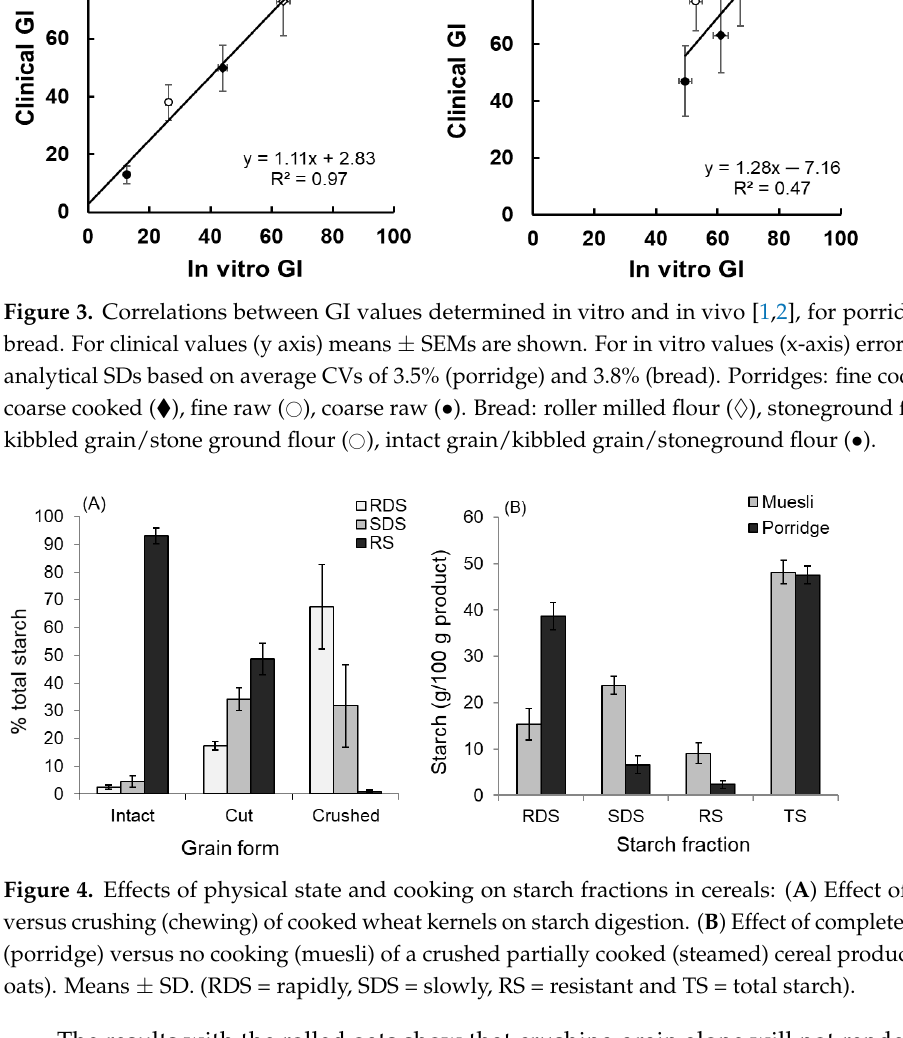
Figure 3. Correlations between GI values determined in vitro and in vivo [1,2], for porridges and bread. For clinical values (y axis) means ± SEMs are shown. For in vitro values (x-axis) error bars are analytical SDs based on average CVs of 3.5% (porridge) and 3.8% (bread). Porridges: fine cooked (◊), coarse cooked ( ♦ ), fine raw ( ○ ), coarse raw (●). Bread : roller milled flour (◊), stoneground flour ( ♦ ), kibbled grain/stone ground flour ( ○ ), intact grain/kibbled grain/stoneground flour (●).